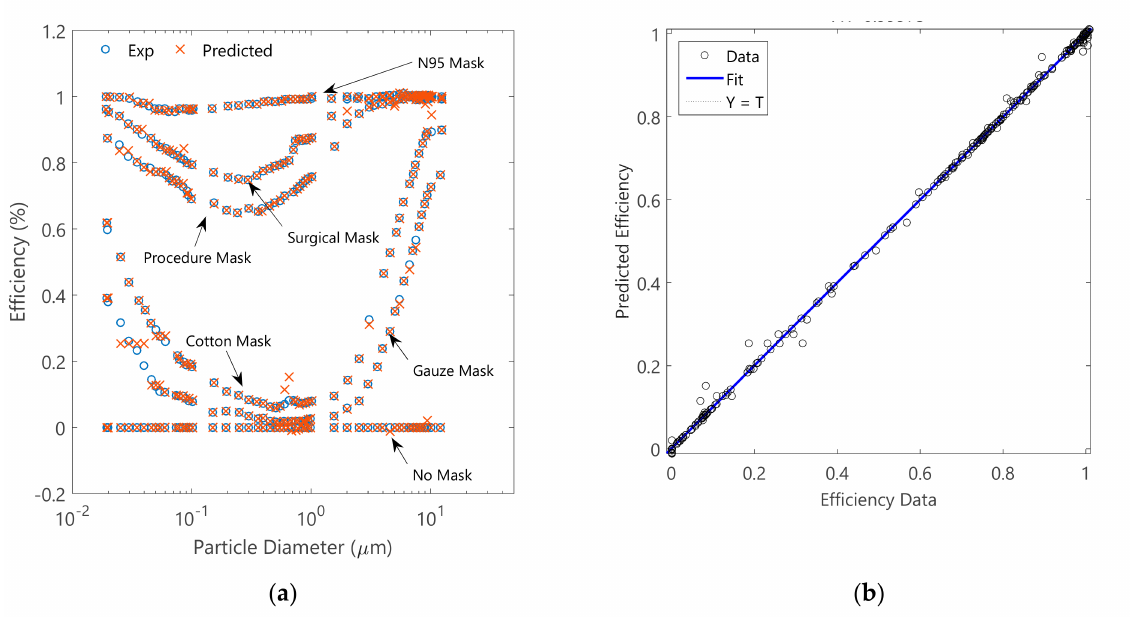
Figure 7. Comparison between the training data [29] and simulation results ( a ), the training correlation ( b